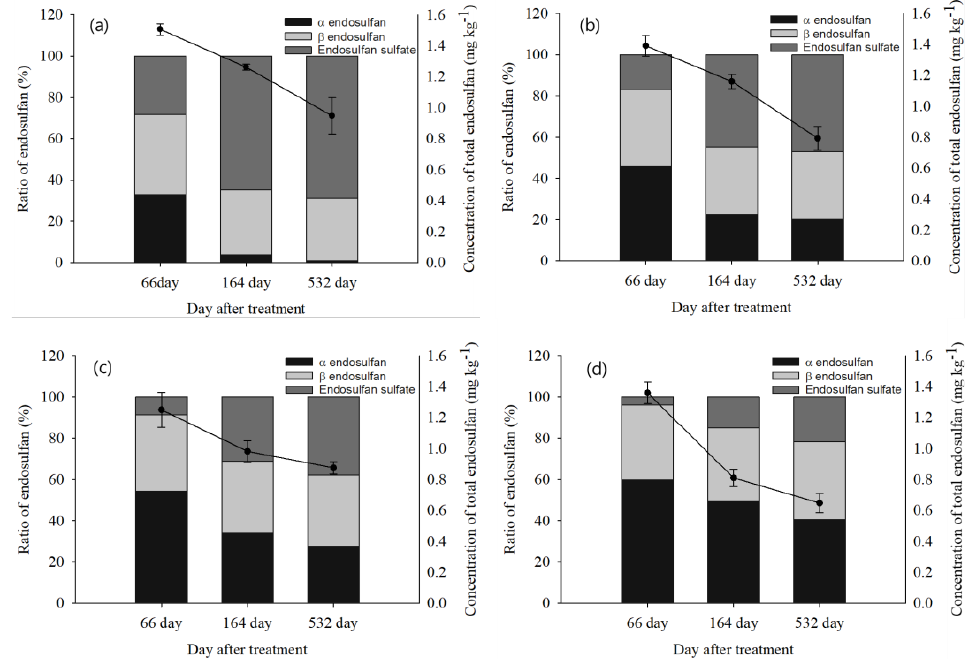
Figure 6. Comparison of the residues of endosulfan over time for different biochar treatments in soil: ( a ) control (non-biochar), ( b ) biochar 0.1%, ( c ) biochar 0.3%, ( d ) biochar 1.0%. Table 4. Repeated ANOVA, Test of Normality between treatments (endosulfan in soil).